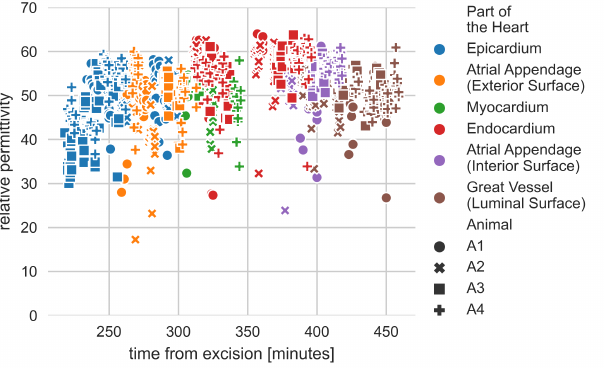
Figure 5. Single frequency (2.4 GHz) relative permittivity measurements versus time from excision in minutes. Different marker colors represent different parts of the heart. Different marker shapes represent measurements on different hearts. There was no obvious trend observed in changes of dielectric properties measured with respect to time from